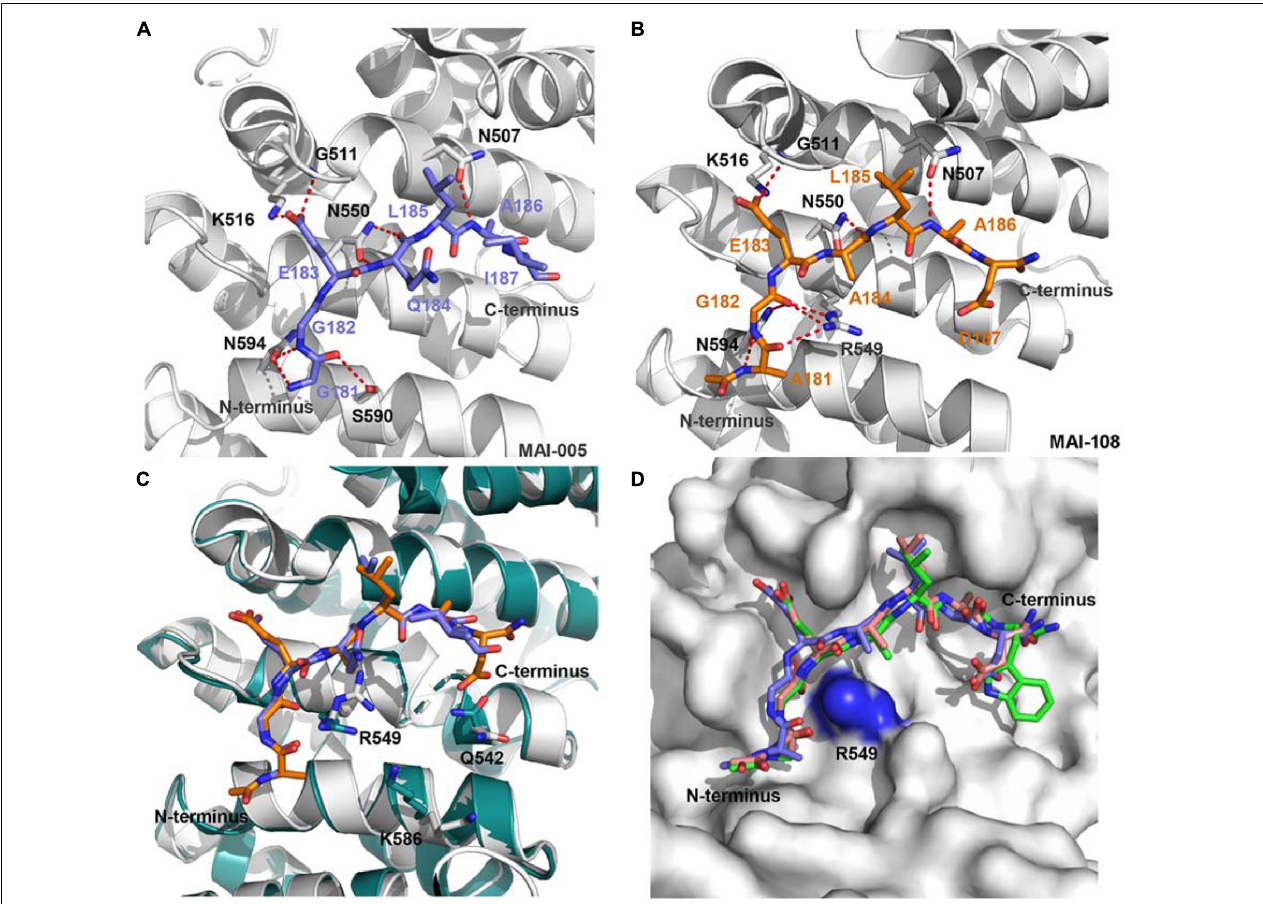
FIGURE 4 | (A) The interactions of APC and MAI-005. APC is shown as a cartoon representation (gray), and MAI-005 is shown as a stick representation (purple). Red dashed lines represent hydrogen bonds. (B) Crystal structure of APC and MAI-108 (5IZ8). APC is shown as a cartoon representation (gray), and MAI-108 is shown as a stick representation (orange). Red dashed lines represent hydrogen bonds. (C) Structure comparison of APC/MAI-005 (APC, cartoon, gray; MAI-005, stick, purple) and APC/MAI-108 (APC, cartoon, cyan; MAI-108, stick, orange). (D) Superimposition of APC/MAI-102 (5IZA), APC/MAI-107 (5IZ9), and APC/MAI-108 (5IZ8) (APC, surface, gray; MAI-102, stick, green; MAI-107, stick, light pink; MAI-108, stick, purple).